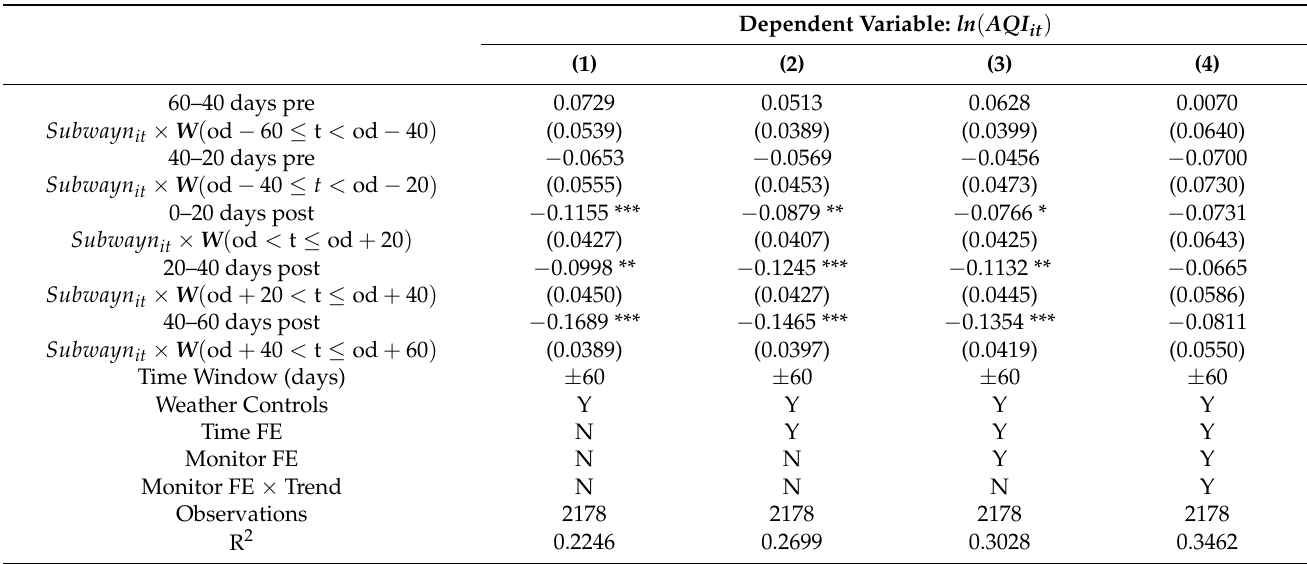
Table 2. Parallel trend